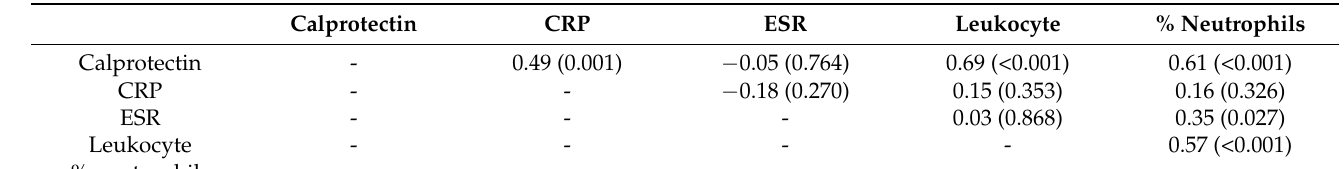
Figure 2. ROC curves for the tests based on serum and synovial markers. The linear relationship between calprotectin values and the other PJI biomarkers is displayed in Table 4. Calprotectin levels were significantly different depending on the result of the esterase test (Figure 3). Table 4. Correlation matrix depicting the correlation coefficients ρ (with p -values) between calpro- tectin and the tested PJI biomarkers.